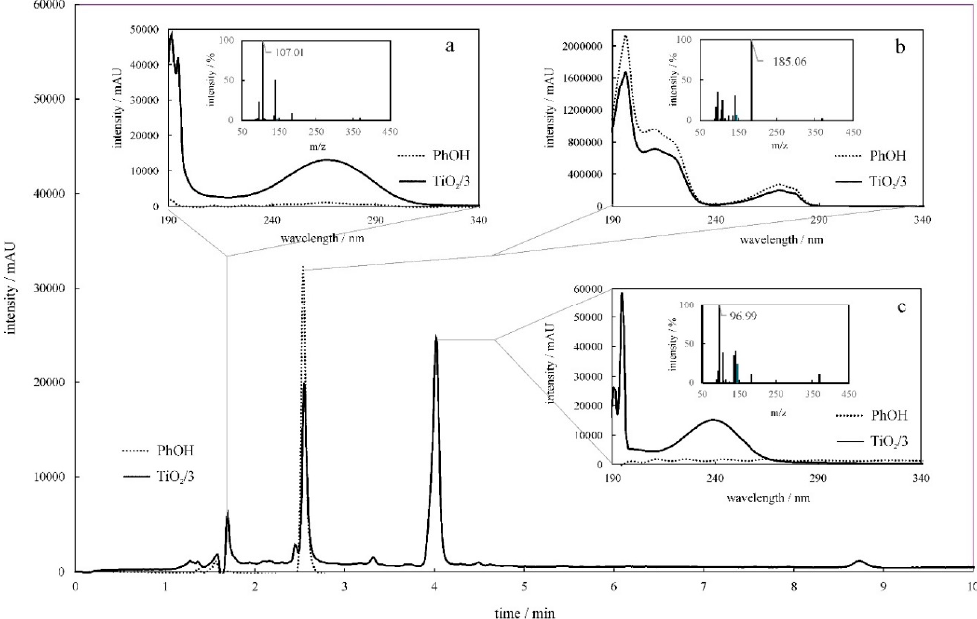
Figure 10. The chromatograms of phenol (PhOH) initial solution ( dotted line ) and after 2 h of photocatalytic treatment ( solid line ) with TiO 2 / 3 , recorded at 239 nm. Absorption spectra corresponding to the peaks are registered in the chromatograms at 1.71 ( a ), 2.56 ( b ), and 4.05 min ( c ). Insets represents mass spectra registered at respective retention times. Molecules 2018 , 23 , x FOR PEER REVIEW